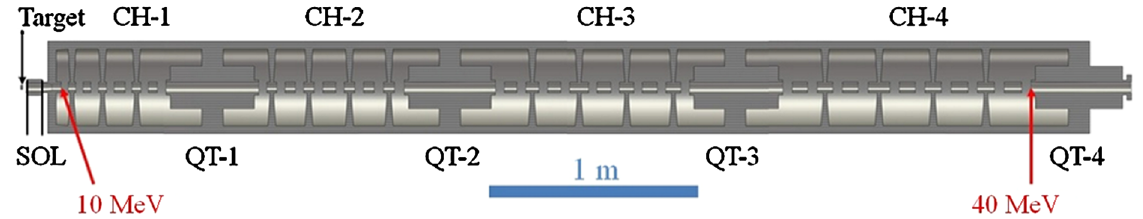
FIG. 22. 3D view on the proposed CH-DTL consisting of four rf cavities separated by triplet quadrupoles. In front of the first cavity, the pulsed solenoid is located and the distance between the end edge of the solenoid and the center of the first gap is 103 mm.